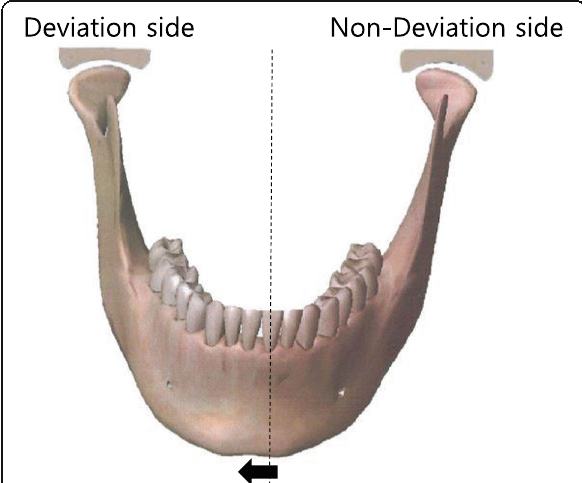
Fig. 1 Facial asymmetry. Among the bilateral mandibular condyles, the deviating side of the mandible was assigned as the deviation side and the other condyle as the non-deviation side. The standard of asymmetry is a Menton (Me) deviation (minimum 3 mm, maximum 7